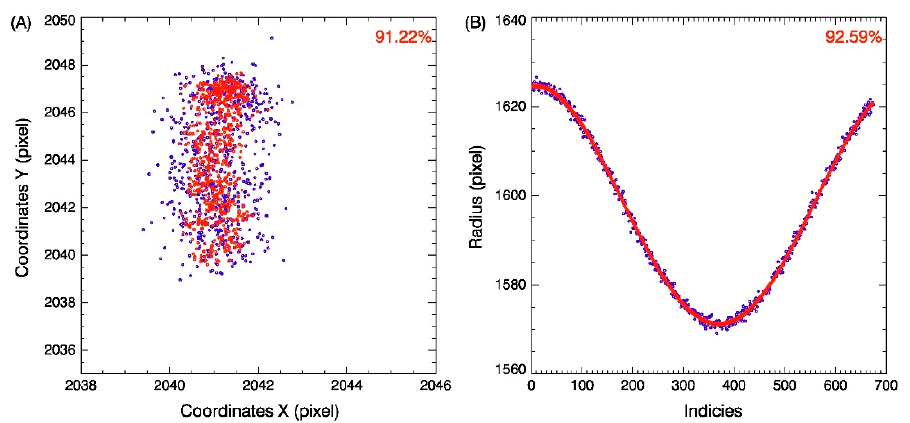
Figure 8. The image data was obtained in 2019, and the solar activity was minimum. ( A ) is the comparison of the 665 samples of solar centers between our calculations (blue points) and the results of AIA (red points), and ( B ) is the comparison of the 675 samples of solar radii between our calculations (blue points) and the results of AIA (red points).